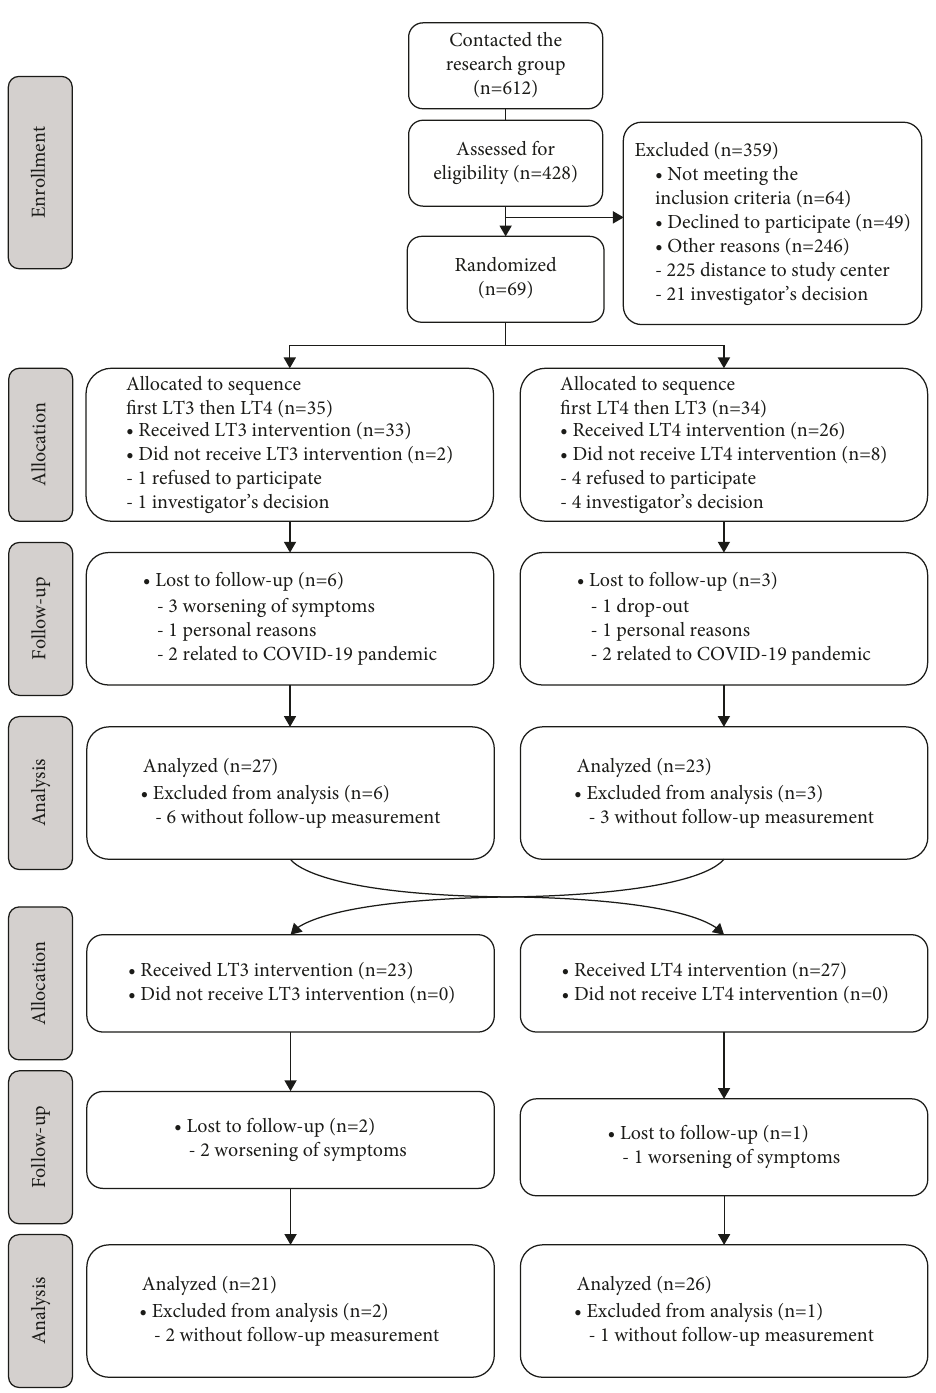
Figure 1: Flow chart showing all subjects approached for the